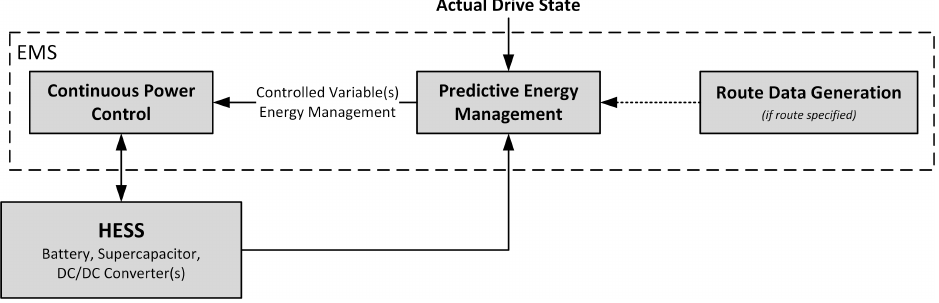
Figure 1. Concept for the architecture of an energy management system for battery and supercapaci- tor